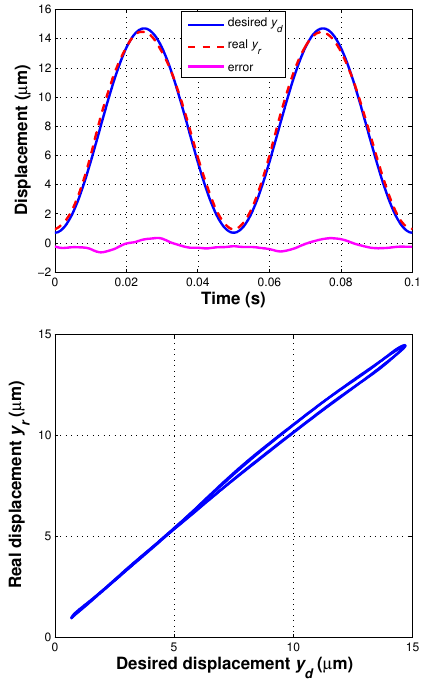
Figure 7. Tracking performance of feedforward controller: ( top ) tracking results, ( bottom ) hysteresis compensation